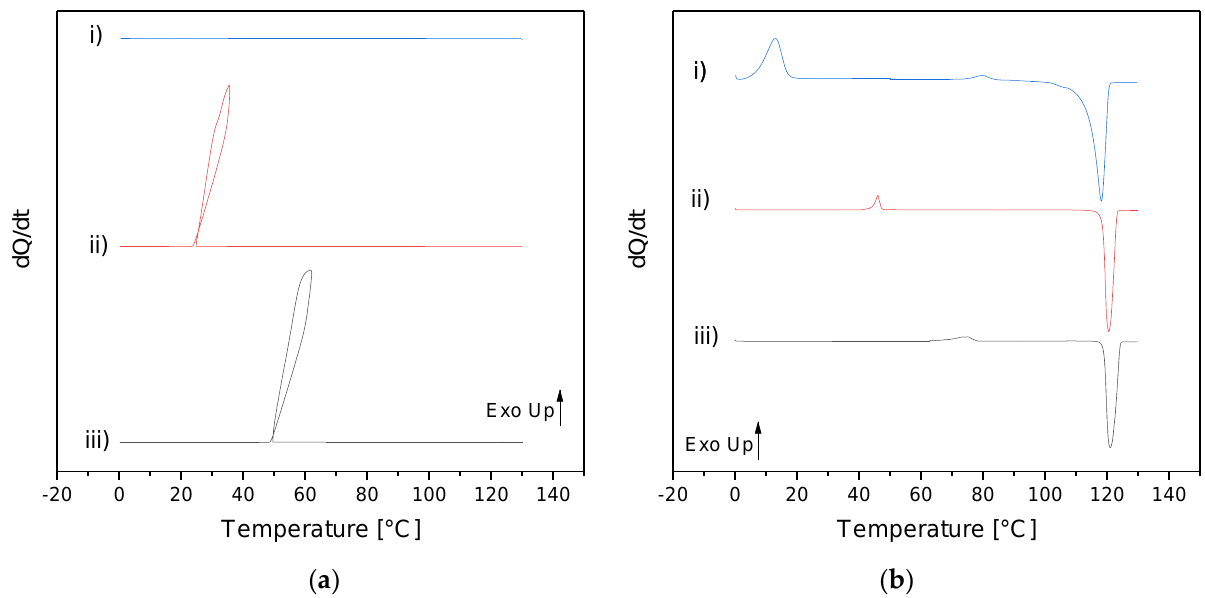
Figure 8. DSC ( a ) cooling and ( b ) heating scans of pure erythritol samples as received (iii), after 50 h (ii) and after 78 h (i) at 141 °C.